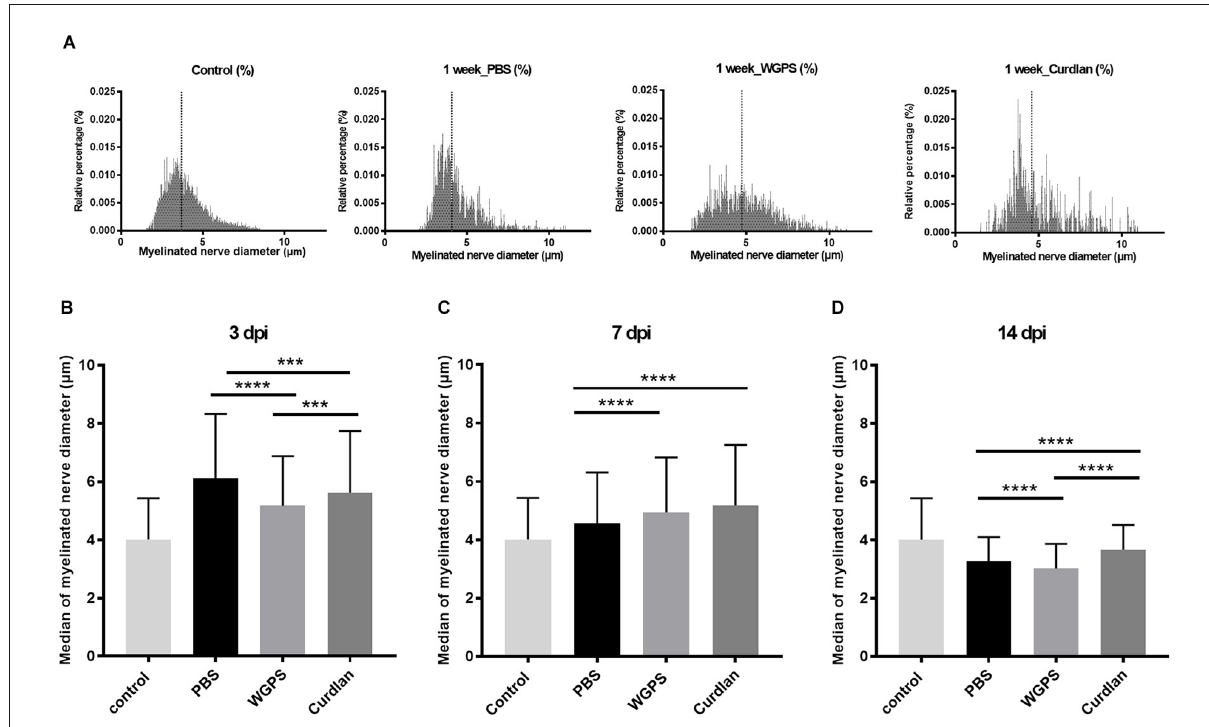
FIGURE6 Histogram and median of myelinated nerve density. (A) Histogram of myelinated nerve diameter distribution percentage from semi-thin section morphometry analysis 7 days after crushing injury in the sham (contralateral), PBS (ipsilateral), curdlan (ipsilateral), and WGPS (ipsilateral) groups. Dotted lines denote the median of each group. (B–D) Medians of myelinated nerve diameter from different groups. (B) The median of myelinated nerve diameter was the smallest in the WGPS injected group 3 days after the crushing injury. (C) The median of myelinated nerve diameter was greater in the WGPS and curdlan groups than in the PBS group 7 days after crushing injury. (D) The median of myelinated nerve diameter is the smallest in the WGPS injected group 14 days after crushing injury. Data are represented as median ± SD ( n : control n = 7, 3 dpi: PBS = 4, WGPS = 3, curdlan = 4; 7 dpi: PBS = 6, WGPS = 3, curdlan = 3; 14 dpi: PBS = 3, WGPS = 3, curdlan = 3), *** p < 0.001, **** p < 0.0001, dpi: day post-injury. Data obtained from the sham surgery (contralateral) side was denoted as “control” in this